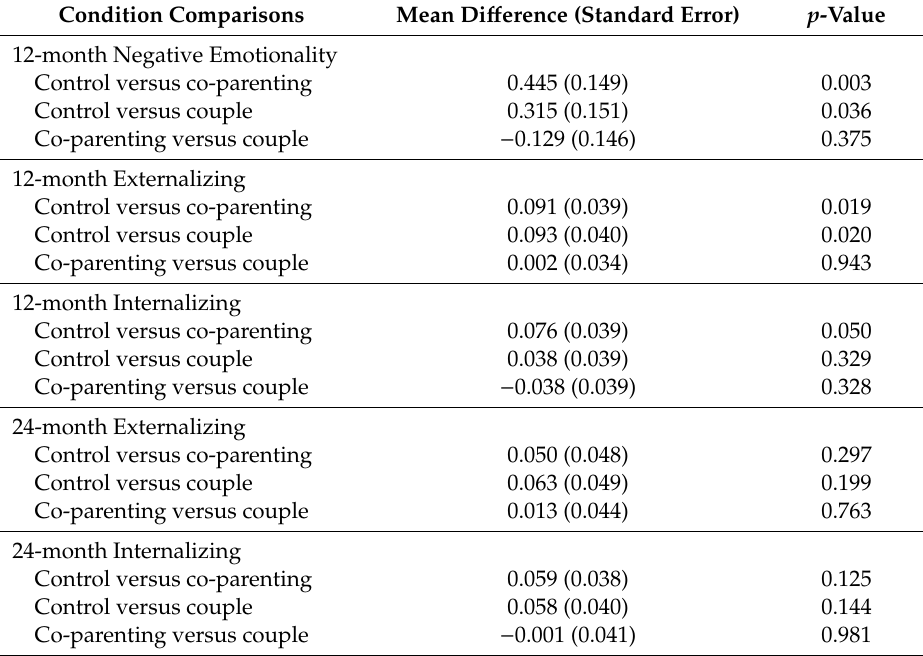
Table 2. Pairwise Comparison of Intervention E ff ects on 12- and 24- month